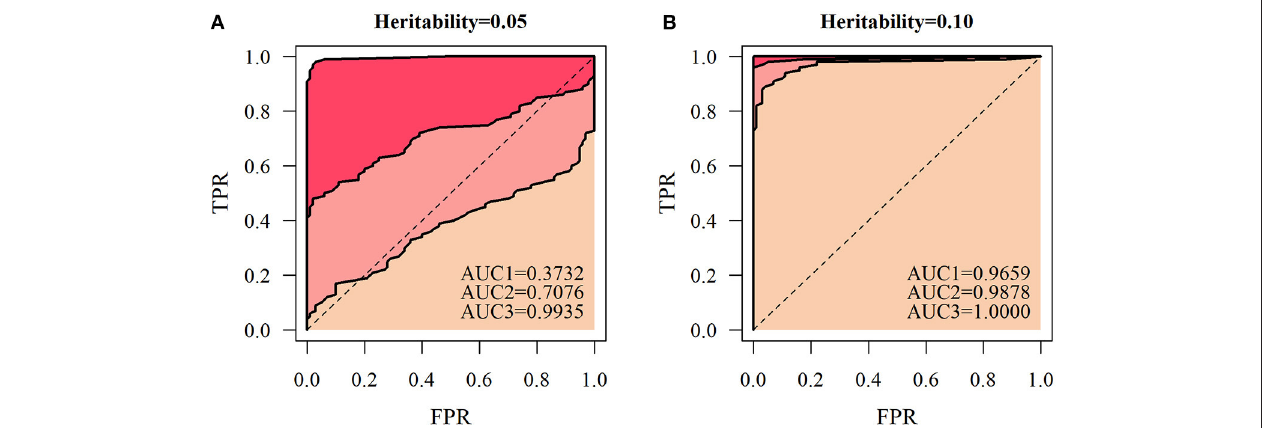
FIGURE 7 | Receiver operating characteristic (ROC) curves of the heritability levels. Let the accuracy of QTL mapping be the ordinate, and the probability of false positives be the abscissa at heritability levels of (A) 0.05 and (B) 0.1 under the three cases of genetic sample sizes of 66, 100, and 200, respectively. Then, AUC1 represents the area under the ROC curve with a sample size of 66, AUC2 represents the area under the ROC curve with a sample size of 100, and AUC3 represents the area under the ROC curve with a sample size of 200.